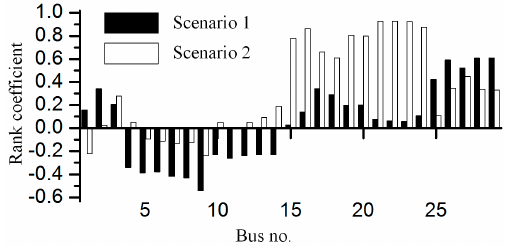
Figure 6. Rank correlation coefficient of DV and SV.